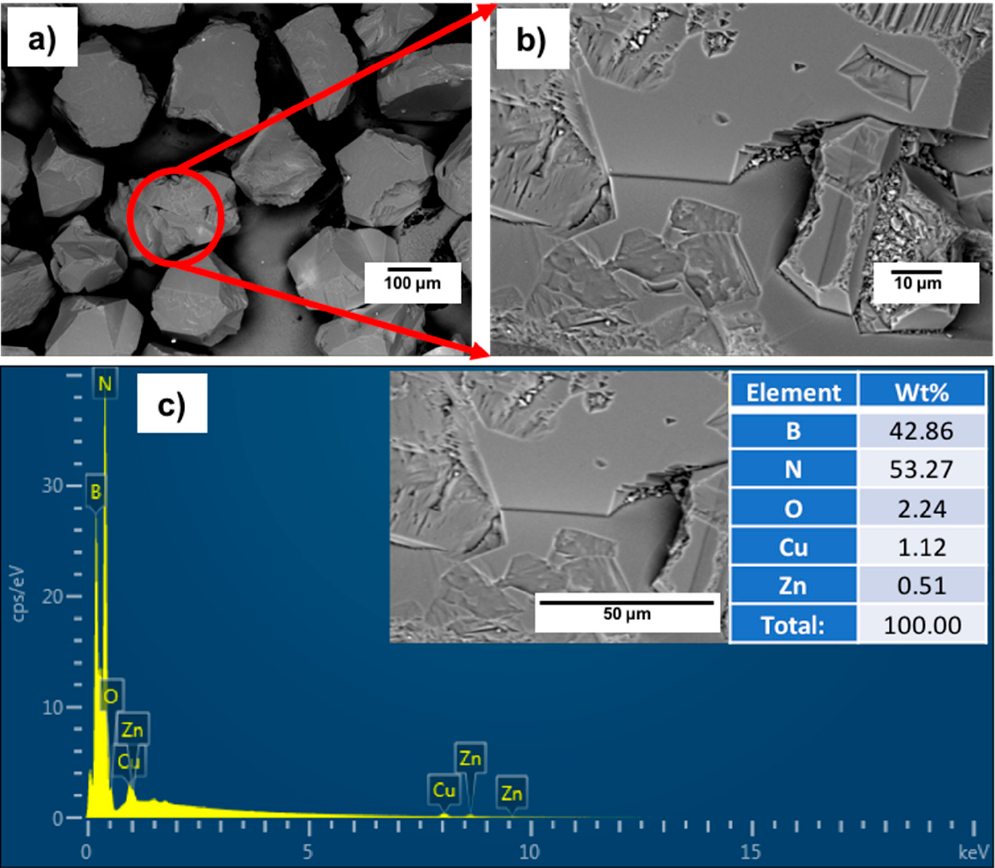
Figure 3. ( a , b ) FESEM images with different magnification and ( c ) EDAX compositional analysis of the investigated polycrystalline cBN abrasive particles.